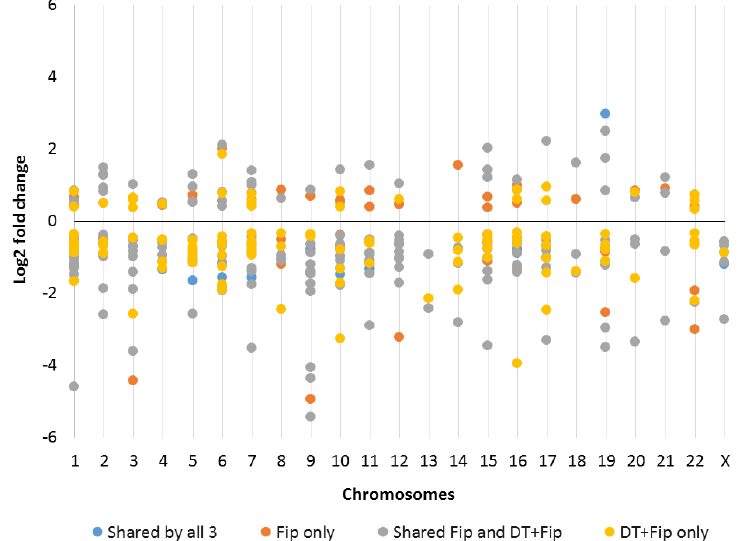
Figure 2. Log2 fold change of transcripts significantly differentially expressed from long non-protein coding RNA genes by chromosome ( p ≤ 0.01). Shared by all 3 means those transcripts were differentially expressed in all three treatments; Fip only means those transcripts were only differentially expressed when hepatocytes treated with 10 µM fipronil; Shared Fip and DT+Fip means those transcripts were only differentially expressed when hepatocytes treated with fipronil or a combination of DEET and fipronil, but not 100 µM DEET alone; and DT+Fip only means those transcripts were only differentially expressed with the combination of DEET and fipronil, but not each treatment alone. A single representative log2 fold change value was used for transcripts that were differentially expressed under more than one treatment condition. * A representative log2 fold change refers to the average log2 fold change for any genes whose transcript expression was affected by more than one treatment, like shared by all 3, where the same genes were dysregulated by all three treatment conditions.